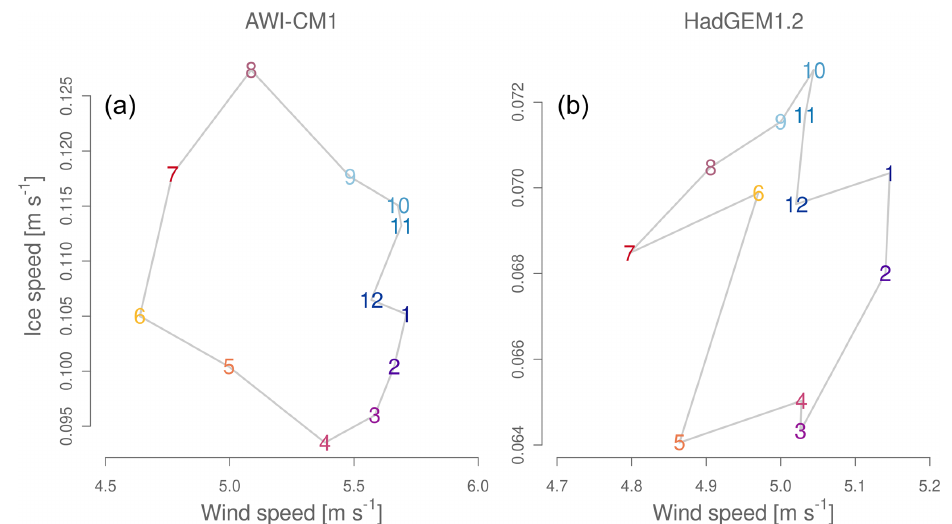
Figure 3. Annual cycles of monthly mean wind and drift speeds on the common subset of initial positions. The numbers indicate the respective months. Please note the strongly different scaling on the